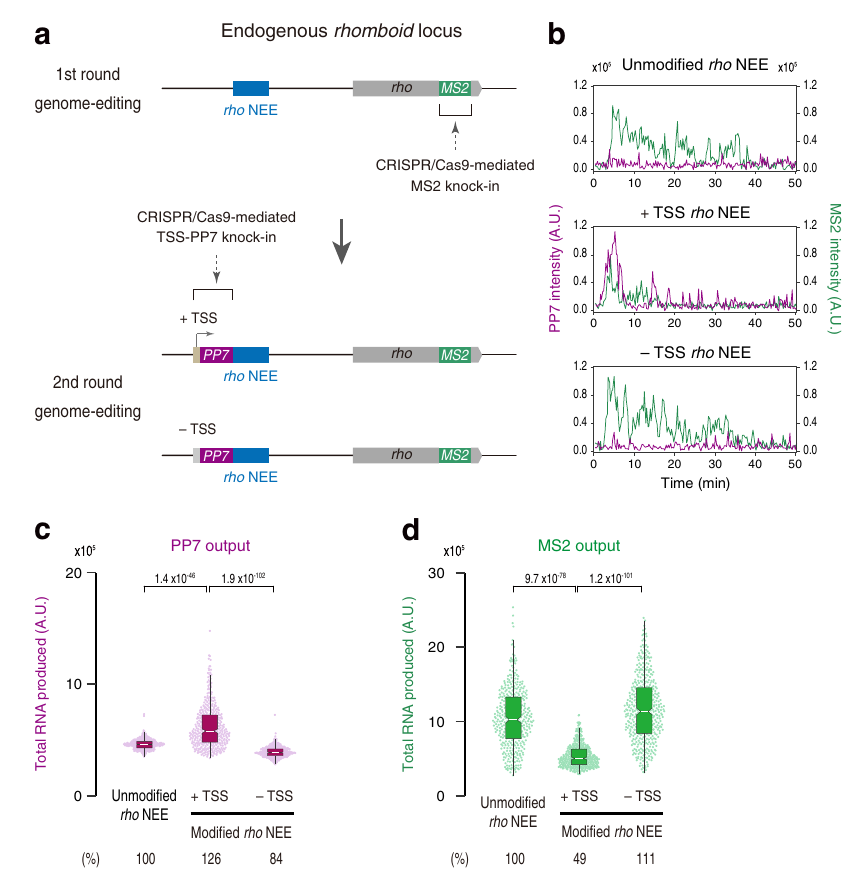
Fig. 7 | Acquisition of novel TSS dramatically reduces endogenous rho expression. a 24x MS2 repeats were inserted into the 3´ UTR of endogenous rho gene (top). Minimal core promoter motifs and 24x PP7 repeats were placed adja- cent to the endogenous rho NEE to drive intergenic non-coding transcription (middle). As a control, 24x PP7 repeats alone were fused with rho NEE (bottom). b Representative trajectories of transcription activities of the endogenous rho locuscontainingunmodi fi ed rho NEE(top),+TSS rho NEE(middle),or − TSS rho NEE (bottom). c Boxplot showing the distribution of the total output of PP7 transcrip- tion.The boxindicatesthelower(25%)and upper(75%)quantileand thewhiteline indicates the median. Whiskers extend to the most extreme, non-outlier data